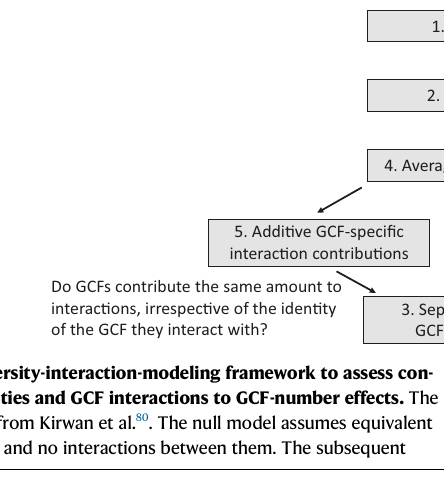
Fig. 4 | Hierarchical diversity-interaction-modeling framework to assess con- tributions of GCF identities and GCF interactions to GCF-number effects. The framework was adapted from Kirwan et al. 80 . The null model assumes equivalent contributions of all GCFs and no interactions between them. The subsequent